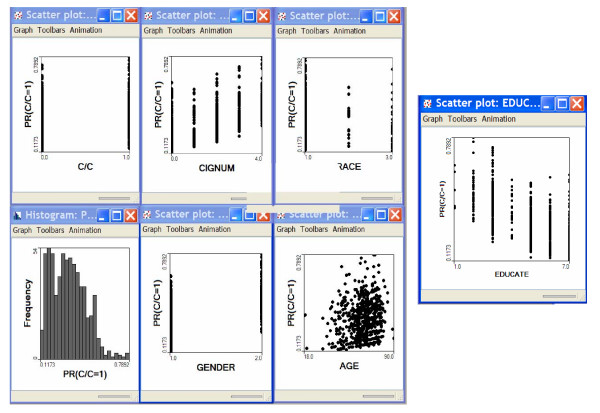
Results from logistic model. "PR(C/C = 1)" is the probability of an individual
being a case given the logistic model and the vector of risk factors and
covariates for that individual. "C/C" indicates the case control identifier, 0
indicates a control and 1 indicates a case. "CIGNUM" is the number of
cigarettes smoked: 0 = never smoked, 1 = smoked < 10 cigarettes daily, 2 =
smoked 11–20 cigarettes daily, 3 = smoked 21–30 cigarettes daily, 4
= smoked > 30 cigarettes daily. "RACE" is 1 = white, 2 =black, 3 = other.
"EDUCATE" is a participant's level of education attained, 1 = <8 years, 2 =
8–11 years, 3 = 12 years or high school graduate, 4 = post high school
training, 5 = some college, 6 = college graduate, 7 = postgraduate education.
"GENDER" is 1 = Male, 2 = Female. "AGE" is the participant's age at time of
interview.